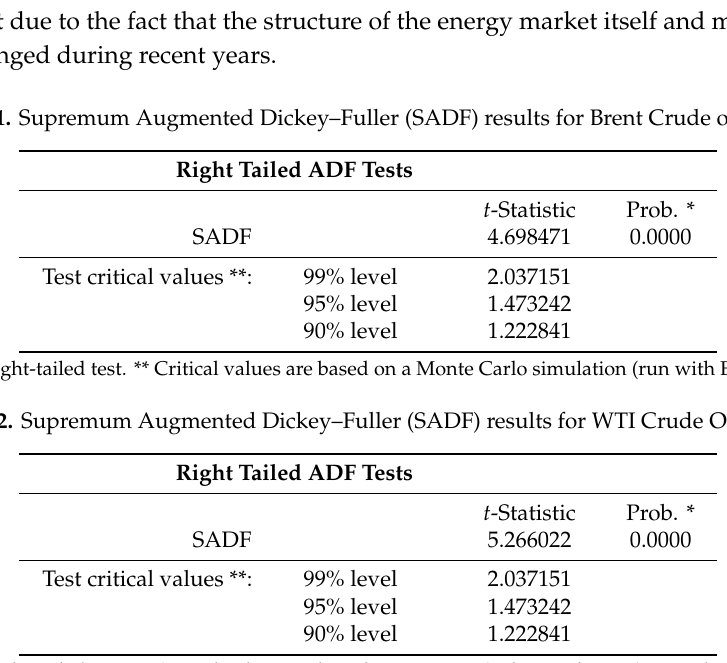
Table 1. Supremum Augmented Dickey–Fuller (SADF) results for Brent Crude oil price.